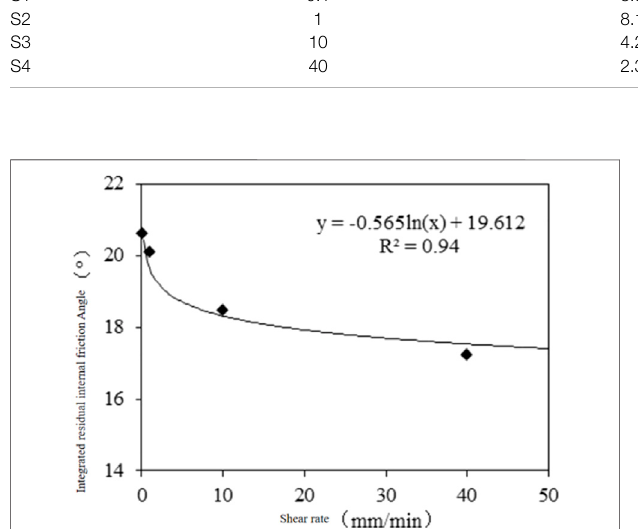
FIGURE 12 | Relationship between shear rate and integrated internal friction angle.